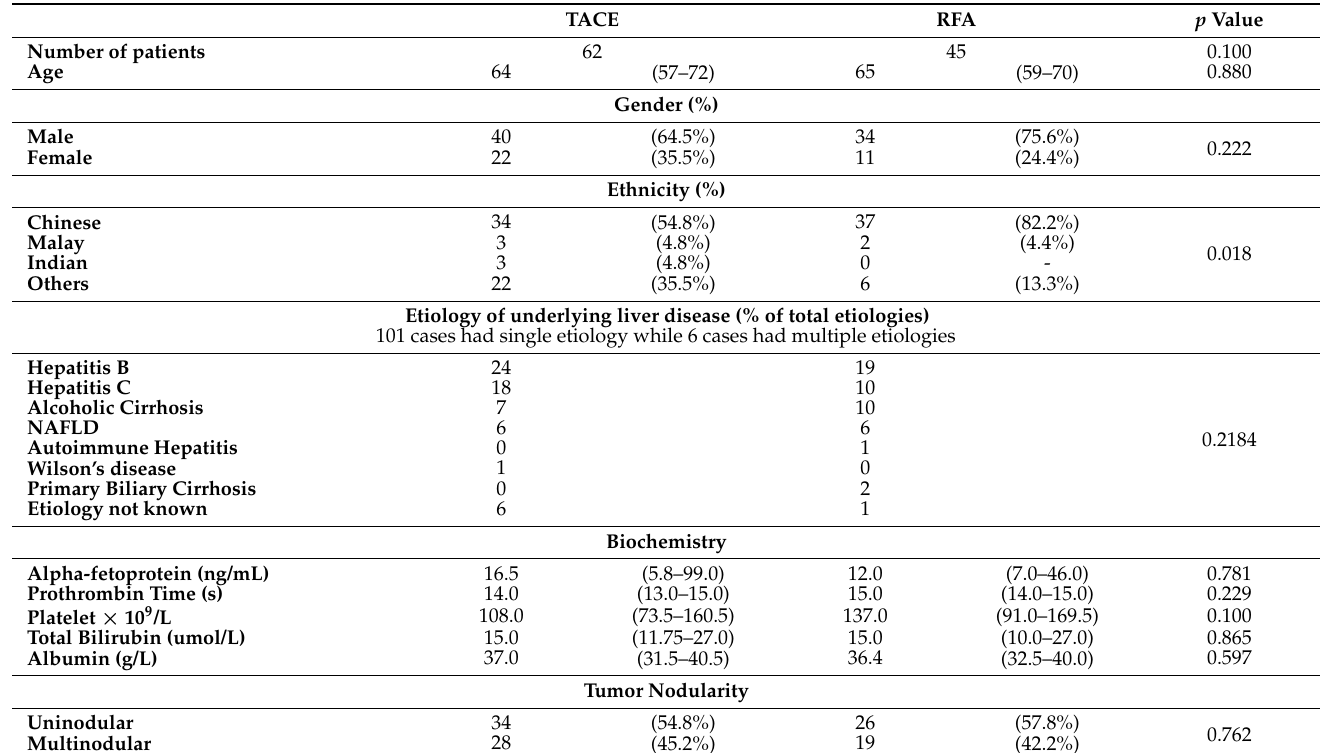
Table 2. Baseline characteristics of patients with primary HCC tumor <3